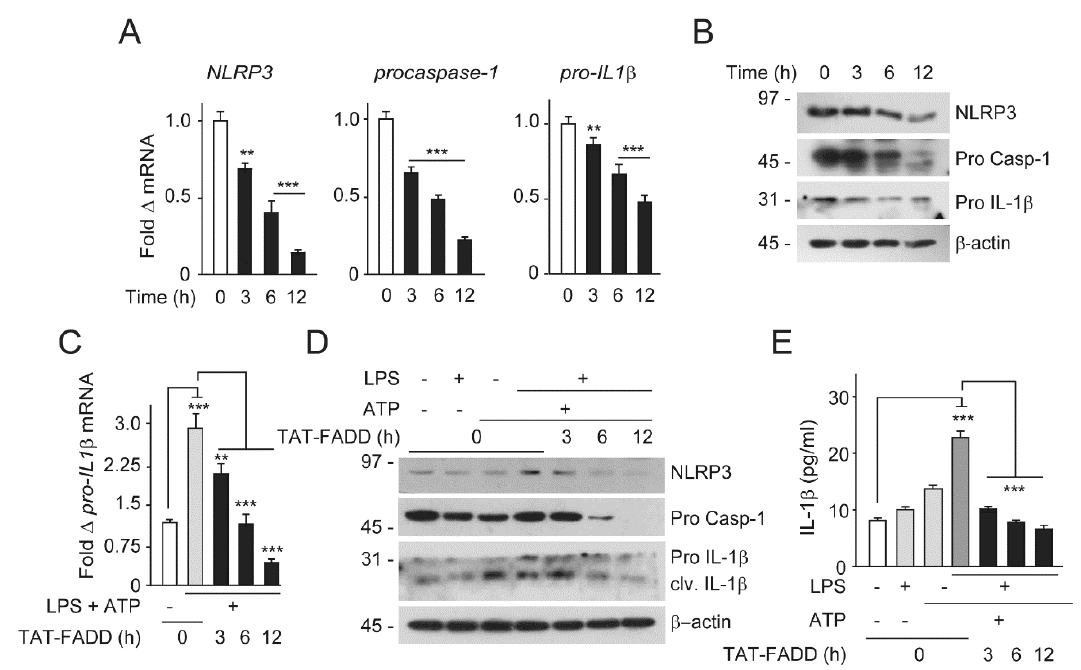
Figure 6. TAT-FADD suppresses proinflammatory activation of IL-1 β . ( A , B ) HCT116 cells were treated with 5 µ M of TAT-FADD for 3–12 h, ( A ) mRNA expression of NLRP3 , procaspase-1 , and pro - IL-1 β , and ( B ) endogenous expression of NLRP3, procaspase-1 (pro Casp-1), and pro IL-1 β by Western blot, molecular weight marker left to each blot. The 0 h represents untreated cells. ( C – E ) HCT 116 cells were primed with LPS (100 ng / mL, 12 h) and ATP (5 mM, 2 h) followed by treatment with 5 µ M of TAT-FADD for 3–12 h and ( C ) mRNA expression of pro-IL-1 β , ( D ) expression levels of endogenous NLRP3, procaspase-1, and pro IL-1 β by Western blot, molecular weight marker left to each blot, and ( E ) levels of matured IL-1 β was measured by ELISA assay from the culture supernatant. In ( C , E ) (white bar) and in ( D ) (lane 1), it represents un-primed and non-treated cells for 12 h taken as controls. In ( A ), significance is compared between non-treated (represents as 0 h) and TAT-FADD-treated cells; in ( C ), significance compared between non-treated (white bars) and LPS with ATP-primed cells (gray bars); and between LPS with ATP primed cells treated with TAT-FADD treated cells (black & dark gray bars respectively). h, hours. Mean ± SD; ** p ≤ 0.01 and *** p ≤